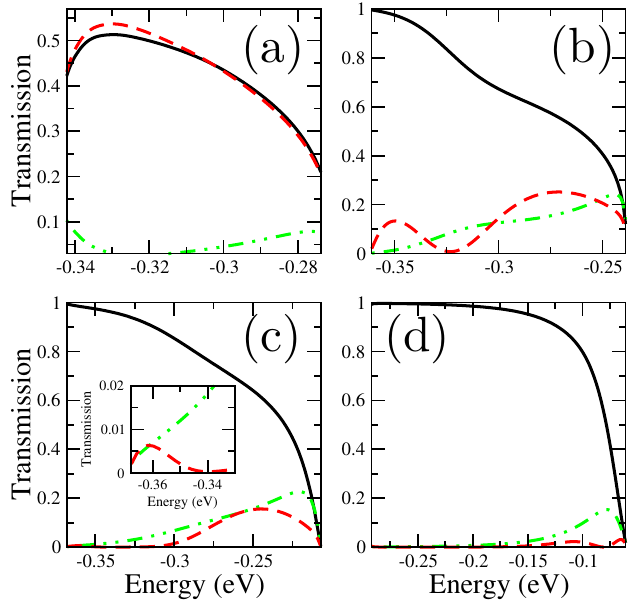
Figure 4. Contributions of the C L dashed double dotted lines) and C L in the heterojunctions for the zGNR-4 ( a ), -6 ( b ), -8 ( c ) and -40 ( d ) in the energy